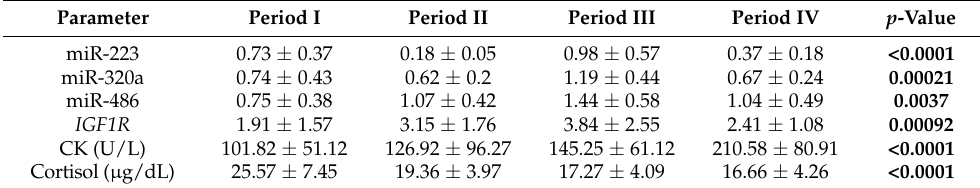
Table 1. Differences in targets expression levels and laboratory parameters between studied periods. Parameter